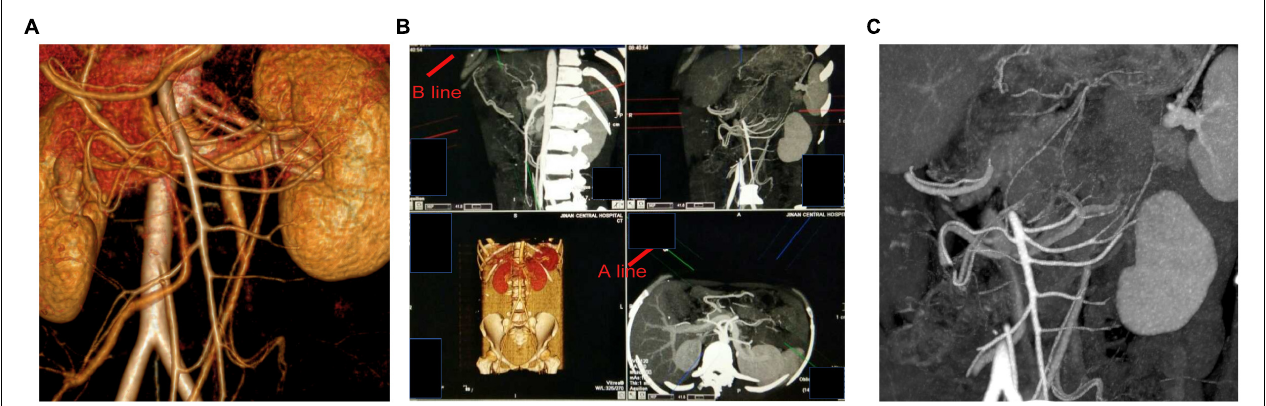
FIGURE 1 | (A) Image processing analysis was performed using a 3D volume rendering (VR) technique with the extended brilliance workspace (EBW). (B) By adjusting the A-line and B-line, we can get the best perspective. (C) The maximum-intensity projection (MIP) images were evaluated using VITAL Image Management System.